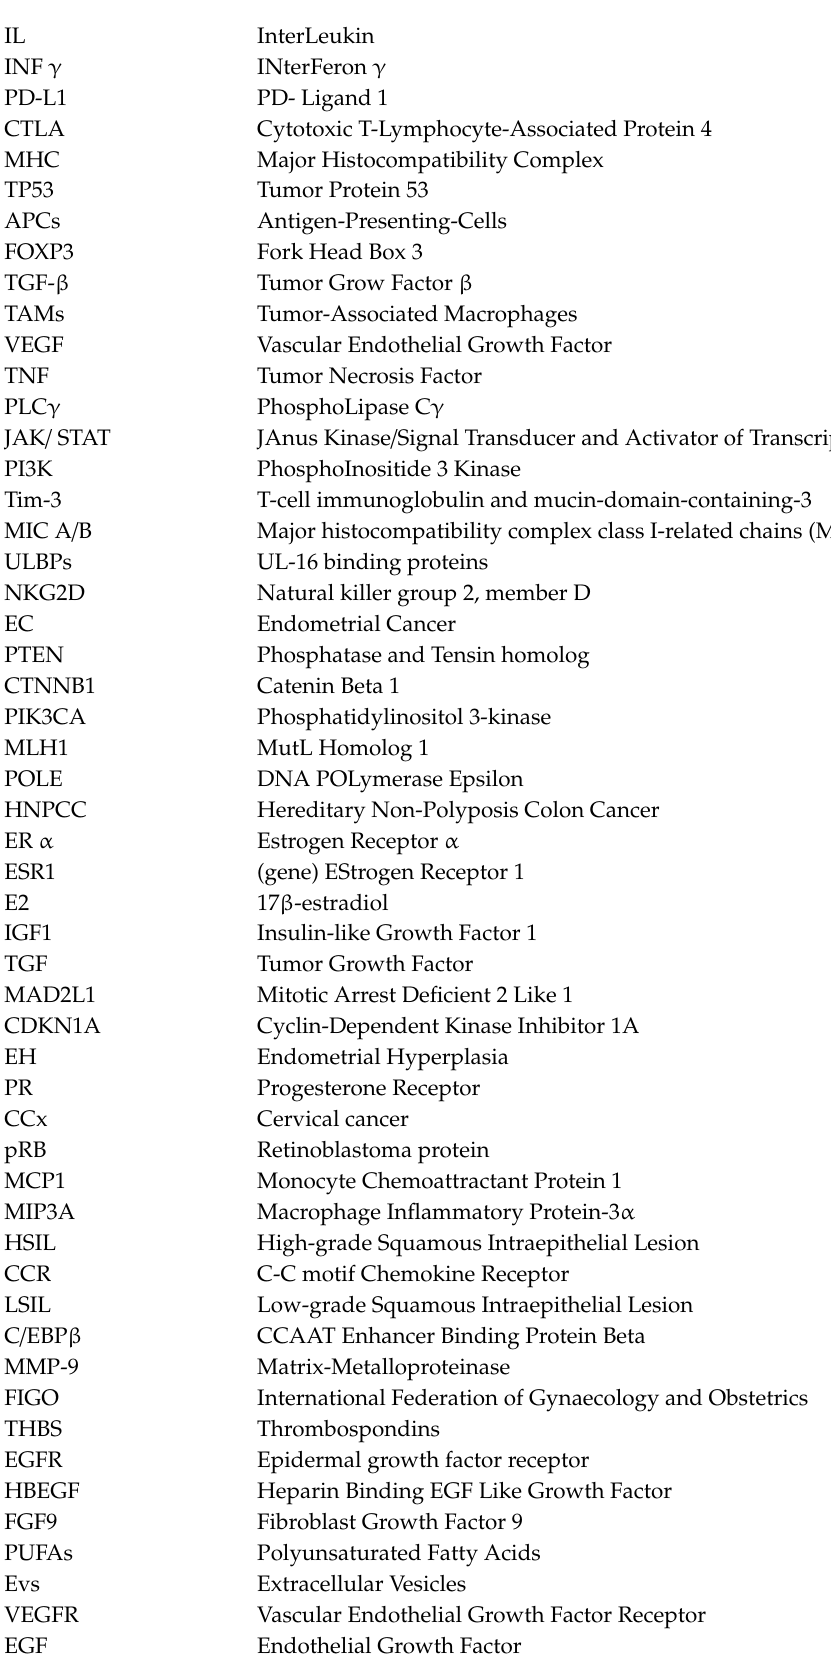
FIGO International Federation of Gynaecology and